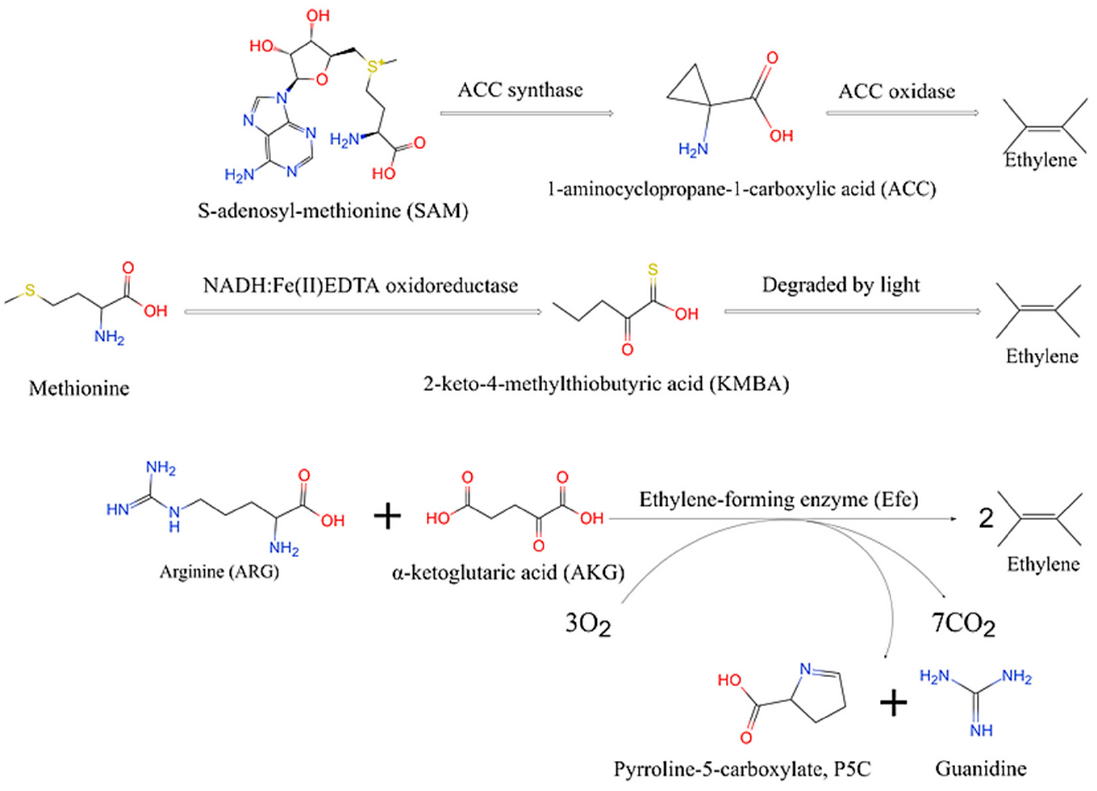
Figure 1. Biosynthetic pathways of ethylene synthesis.